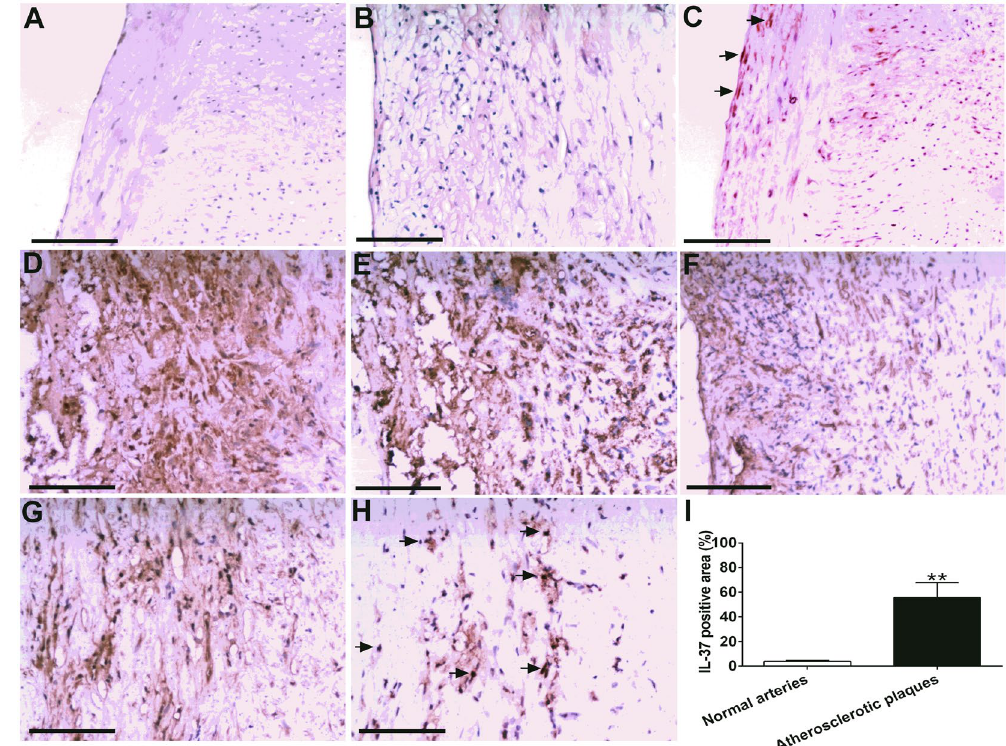
Figure 1. Over-expression of IL-37 in human atherosclerotic plaques. ( A ) Normal human anterior tibial artery stained with hematoxylin-eosin. ( B ) Human atherosclerotic plaque. ( C ) Little IL-37 expression in ECs and VSMCs in normal artery (indicated by arrowheads). ( D ) Abundant IL-37 expression in foam cells in atherosclerotic plaque. D through F, IL-37 expression ( D ) in macrophages identified by anti-CD68 antibody ( E ) and VSMCs identified by anti- α -SMA antibody ( F ). IL-37 expression ( G ) in T lymphocytes identified by anti-CD3 antibody ( H ). ( I ) Results of statistical analysis of IL-37 expression in normal arteries and atherosclerotic plaques. Values are presented as the means ± SEM, n = 8. Black bar = 200 μ m. ** p <